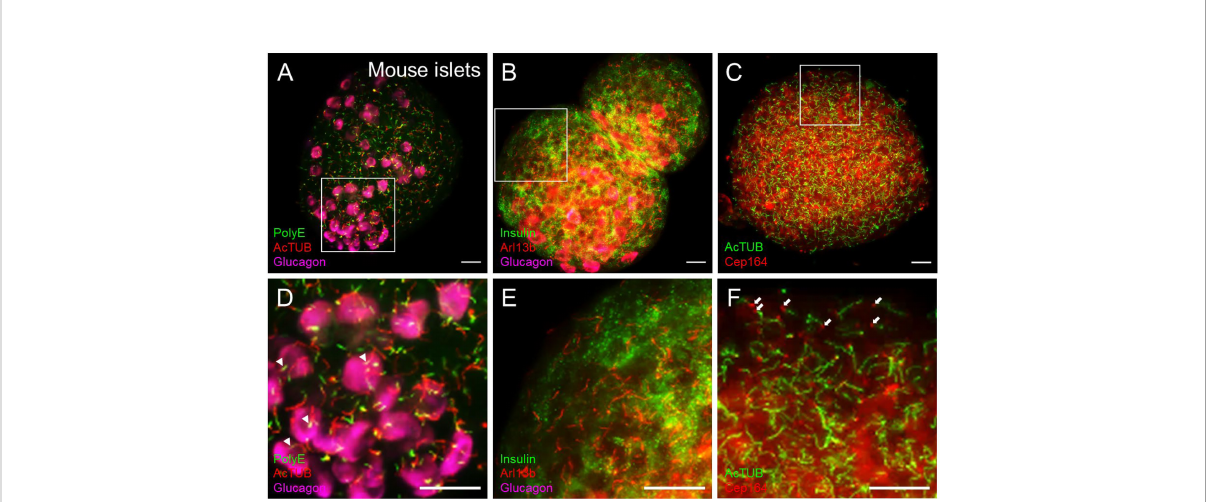
FIGURE 4 Cilia and centriole protein markers produce distinct staining patterns in islets. (A) Dual-labeled cilia in intact mouse islets showing polyglutamylated tubulin (PolyE, green) and acetylated a -tubulin (AcTUB, red) in a maximal projection. AcTUB and PolyE label different parts of the axoneme, which is better visualized in the magni fi ed panel in (D) Alpha cells are labeled by glucagon (magenta). (B) The small GTPase Arl13b labels the cilia axoneme but can also have non-ciliary signal throughout the islet. A relatively “ clean ” region is shown in magni fi ed panel (E) Beta cells are labeled by insulin (green), and alpha cells labeled by glucagon (magenta). (C) Cilia and basal body co-labeling using axonemal marker acetylated a -tubulin (AcTUB, green) and centriole marker Cep164 (red), showing differential localizations of the two proteins. Cep164 antibody also produces cytosolic and nuclear staining that is less focally intense than ciliary signals and may be reduced with antigen retrieval methods. (D – F) Magni fi ed insets from (A-C) , respectively. White arrowheads in panel (D) , proximal segment of cilia. White arrows in panel (F) , basal bodies. All scale bars, 20